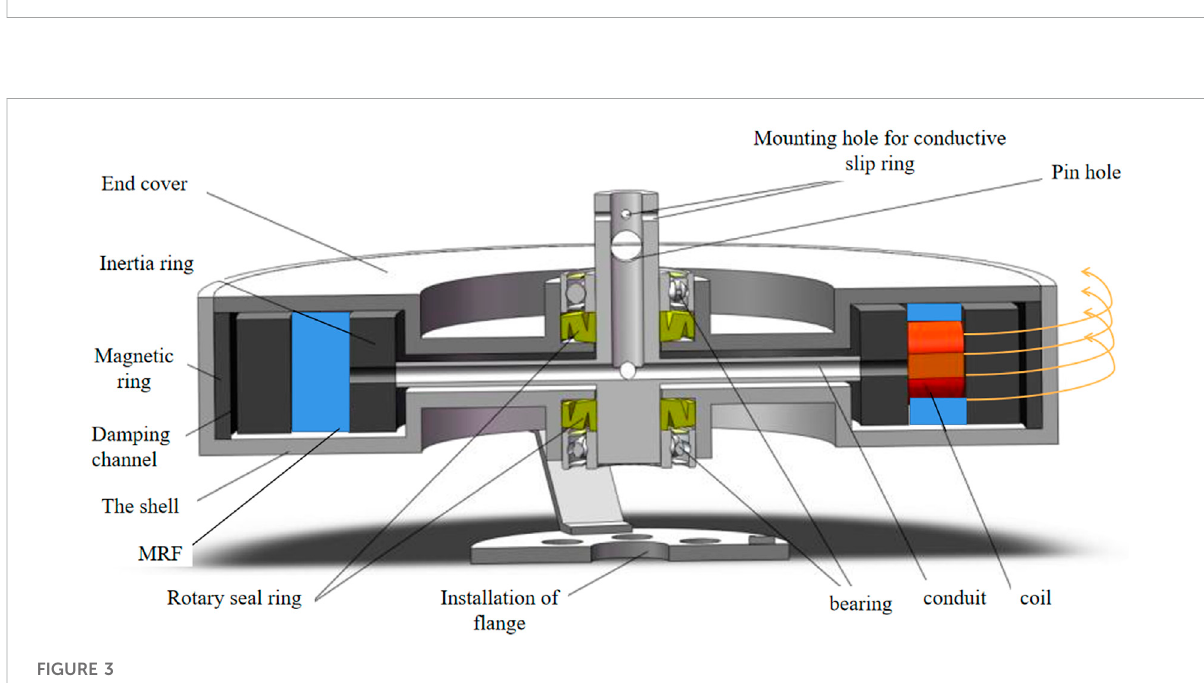
FIGURE 3 MRTD model